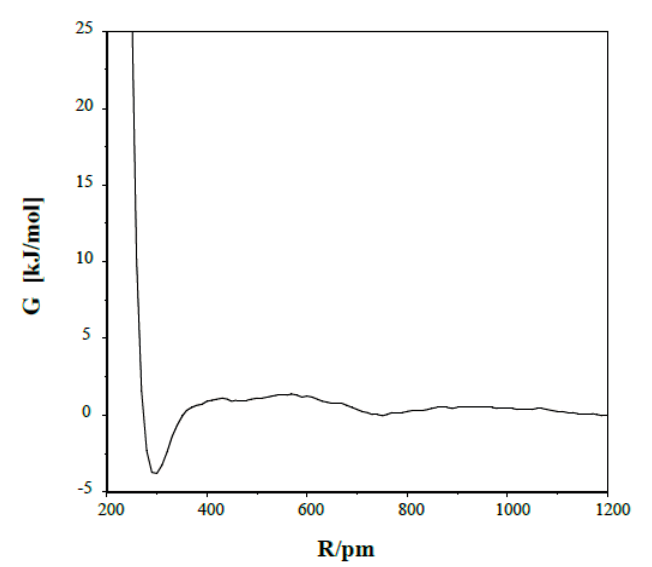
Figure 2. Potential of mean force for the s-trans/anti dimer in